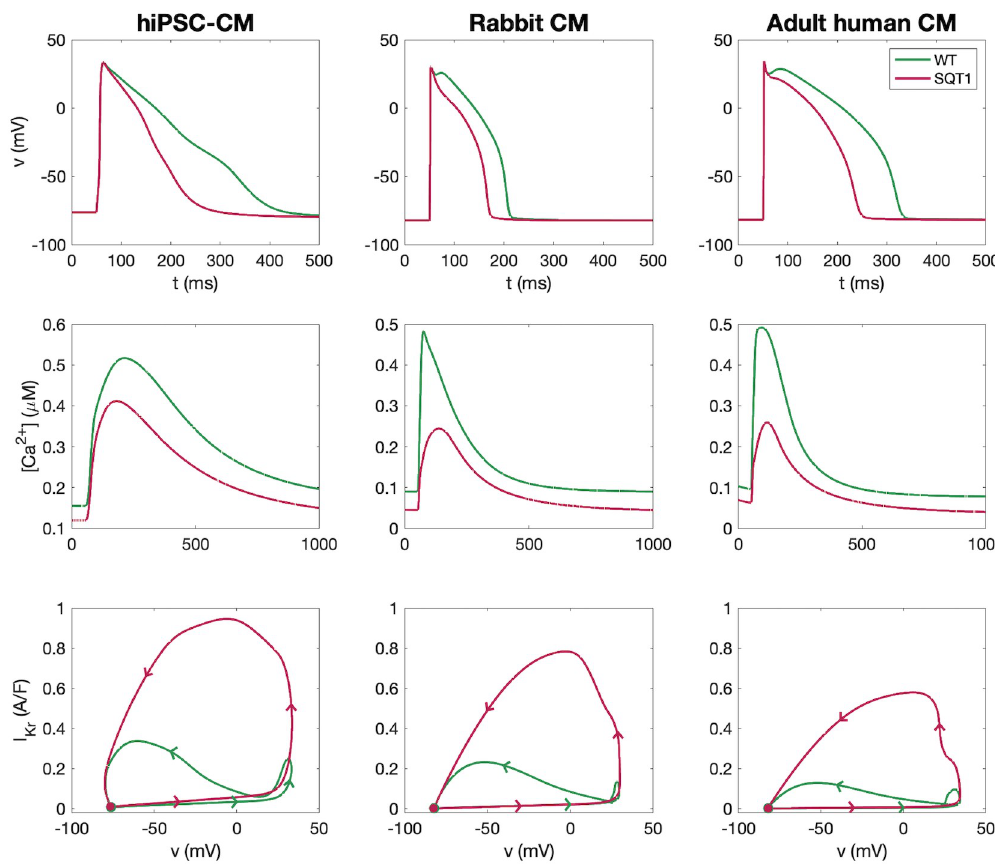
Fig 2. Action potentials, Ca 2+ transients and I Kr currents generated using our models for wild type and SQT1 hiPSC-CMs, rabbit ventricular CMs and adult human ventricular CMs. Each panel in the upper row shows the action potentials in the wild type and SQT1 cases, and the middle row shows the Ca 2+ transients. In the lower row, the I Kr current from each action potential simulation is plotted as a function of the membrane potential during the entire AP waveform. Here, the filled circles mark the solution at t = 0 and the arrows indicate the direction with time. Data used in this figure can be found in S1 Data.